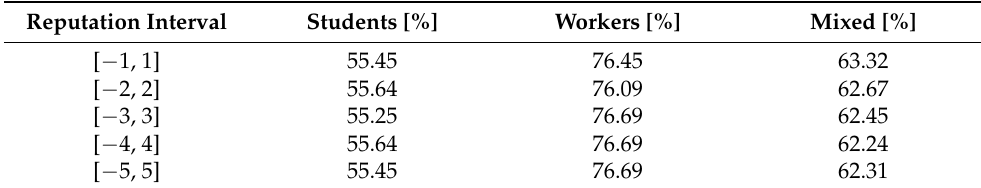
Table 3. Coverage for different reputation intervals on all three